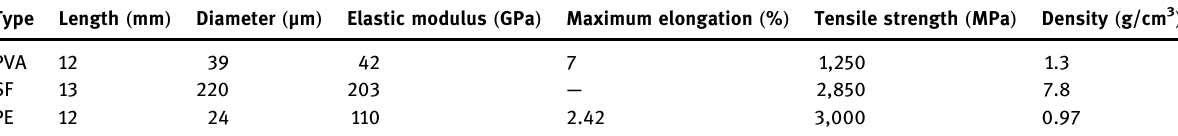
Table 1: Mechanical and geometrical properties of fi bers